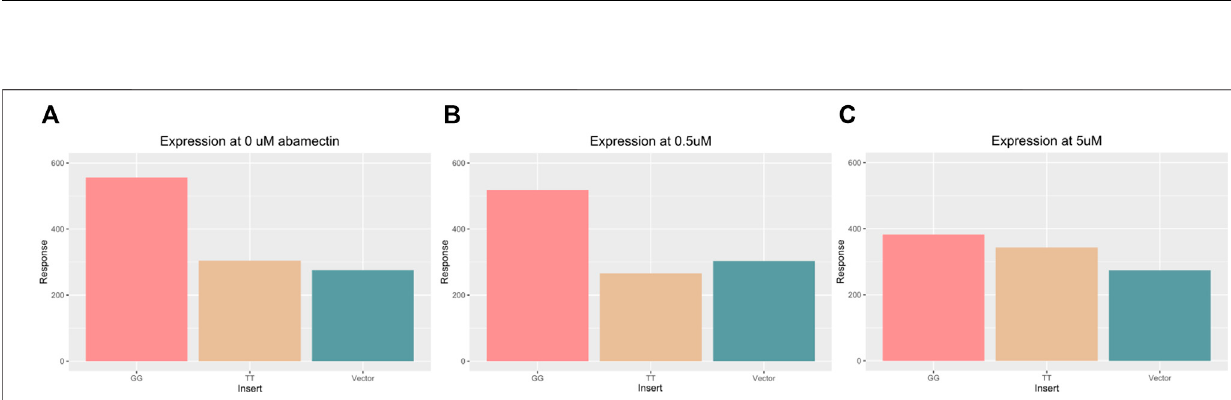
FIGURE 6 | Bar chart displaying the average luciferase activity across three different vector inserts (GG, TT, and control) at 0 μ M (A) and 0.5 μ M (A) and 5 μ M abamectin (C) . The GG vector (left most) has higher expression in all three environments. The TT vector (middle) and control vector (right most) look similar and show lower expression except in response to the highest level of abamectin